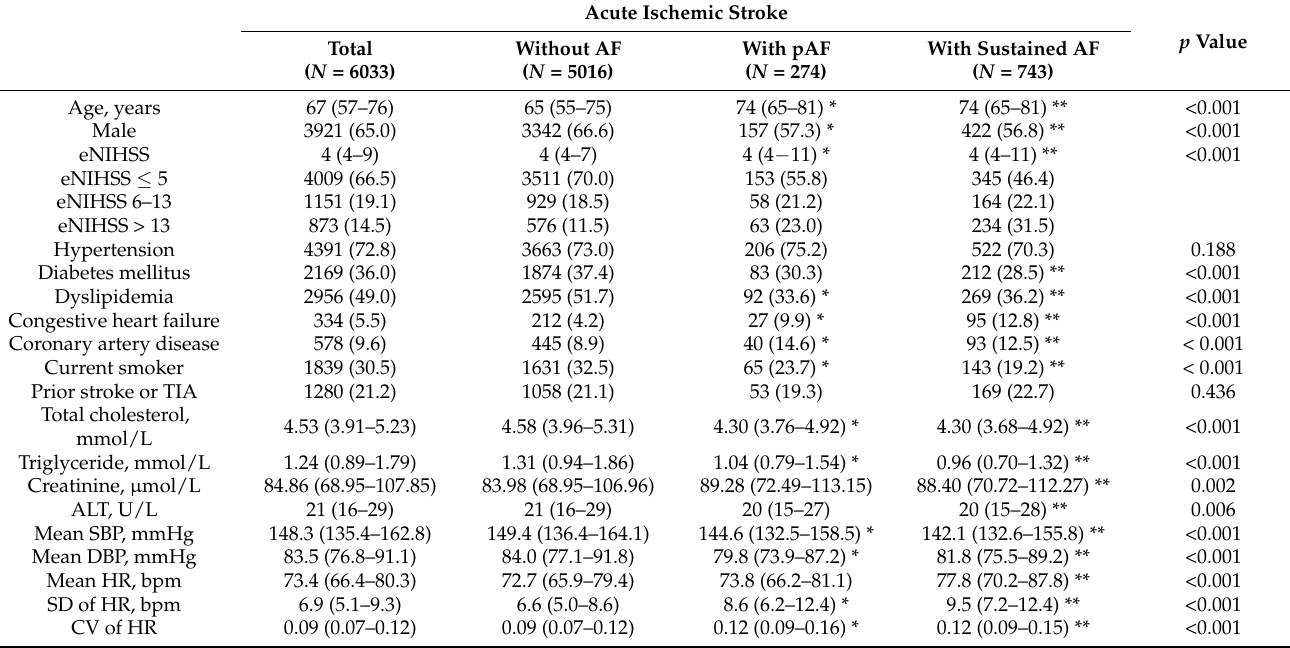
Table 1. Baseline characteristics of the study